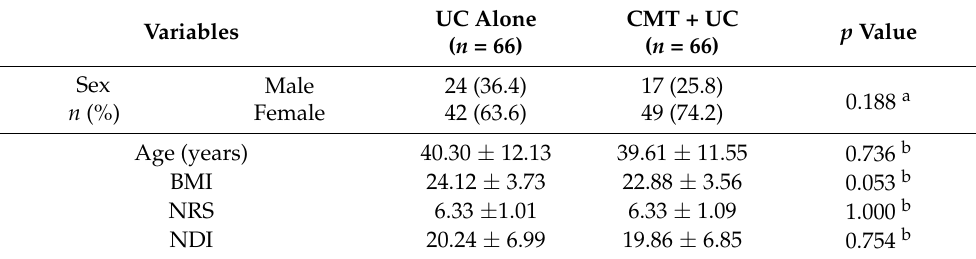
Figure 3. CONSORT flow diagram. Chuna, Chuna manual therapy; UC, usual care. Table 1. Baseline characteristics of patients.